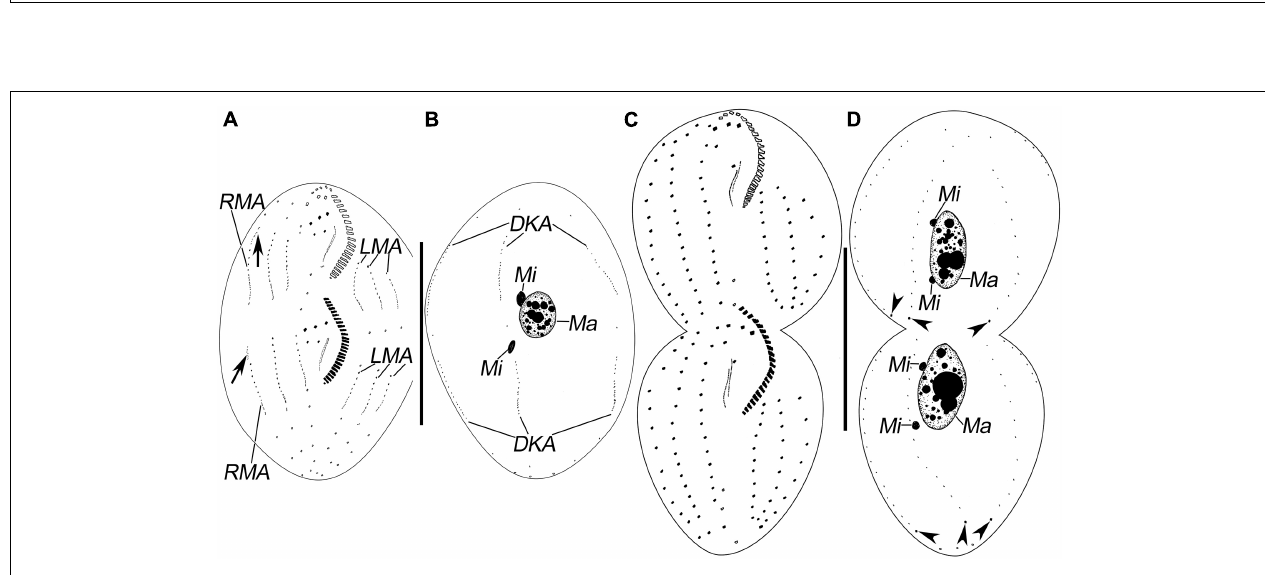
FIGURE 3 | Morphogenesis of Pseudosincirra longicirrata nov. gen. and nov. comb. after protargol staining. (A,B) Ventral and dorsal views of a middle divider; arrows show the dorsomarginal kinety anlagen. (C,D) Ventral and dorsal views of a late divider to show the infraciliature; arrowheads point to the caudal cirri. DKA, dorsal kinety anlagen; LMA, left marginal anlagen; Ma, macronuclear nodules; Mi, micronuclei; RMA, right marginal anlagen. Scale bars = 100 µ m.